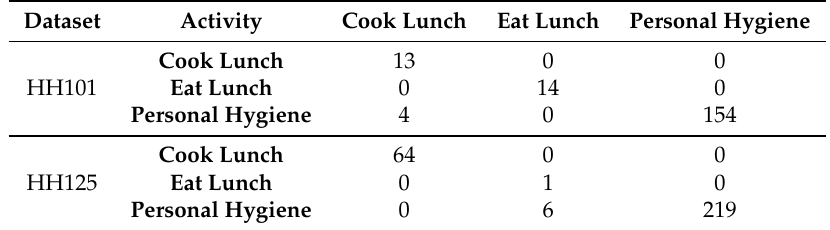
Table 8. Confusion matrix for zero-shot activity recognition—Scenario 2.